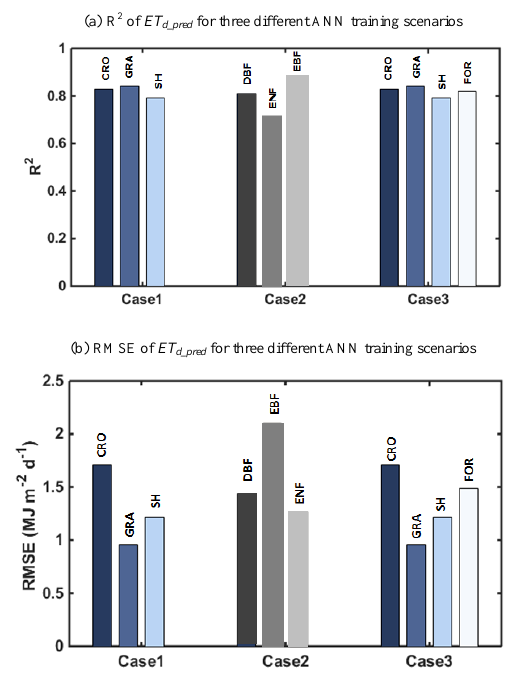
Figure 13. Illustrative examples of the sensitivity of ET d_pred error statistics ( R 2 and RMSE) to the different biome type scenarios of ANN training. Here, Case1 consist of training the ANN with for- est (FOR) datasets and evaluating ANN predicted ET d statistics on non-forest biomes, Case2 consist of training the ANN with non- forest datasets and evaluating ANN predicted ET d statistics on for- est biomes, Case3 consist of training the ANN with both forests and non-forest datasets and evaluating ANN predicted ET d statistics on all the